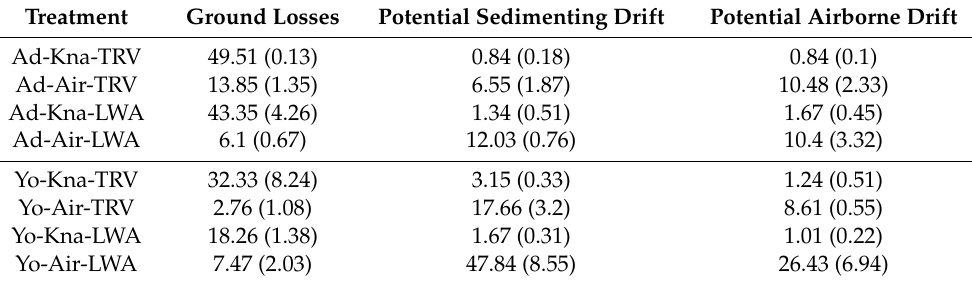
Table A2. Accumulated o ff -target losses (mean (s.e.), µ L cm − 2 ) for each treatment combination of plot–sprayer–dose